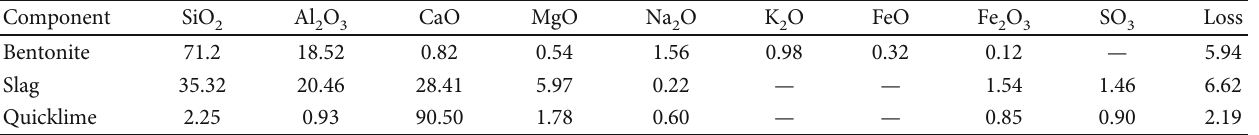
Table 1: Chemical composition of the test materials